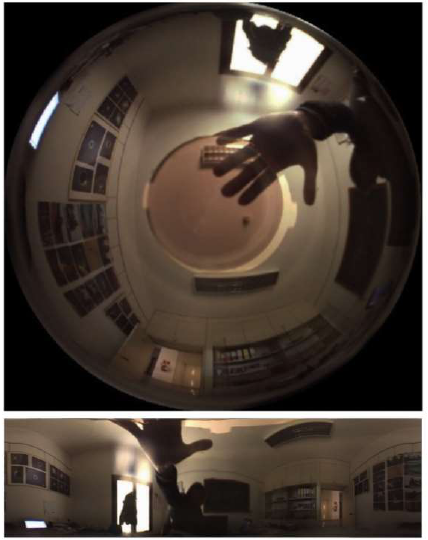
Figure 1 The first HH lens prototype acquired image (top panel). Dewarped image, solely for the panoramic field (bottom panel).